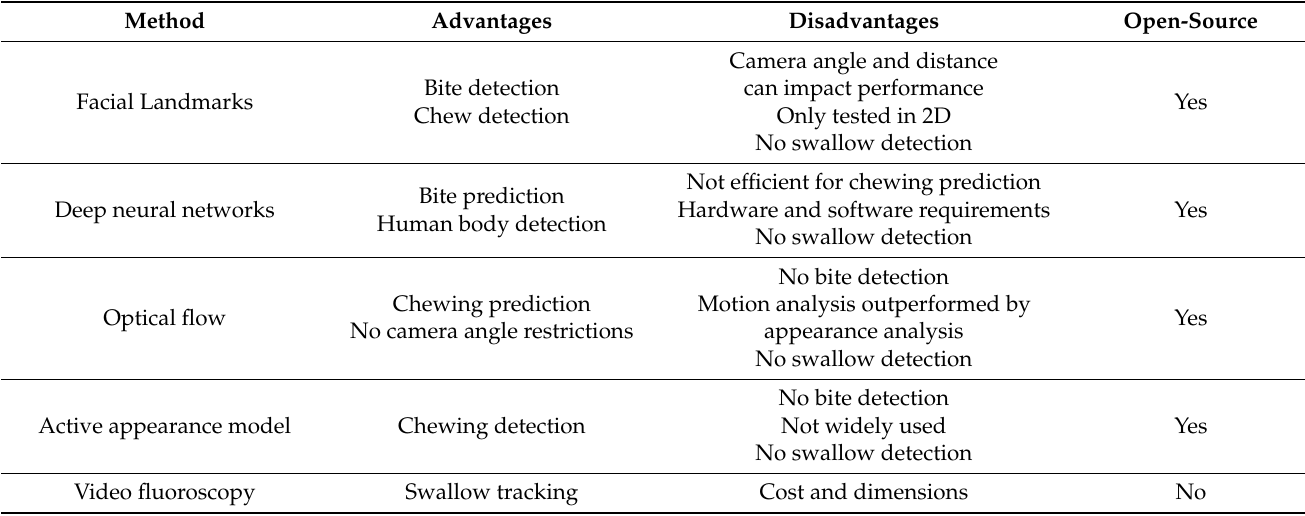
Table 2. Advantages and disadvantages of each method reviewed in this